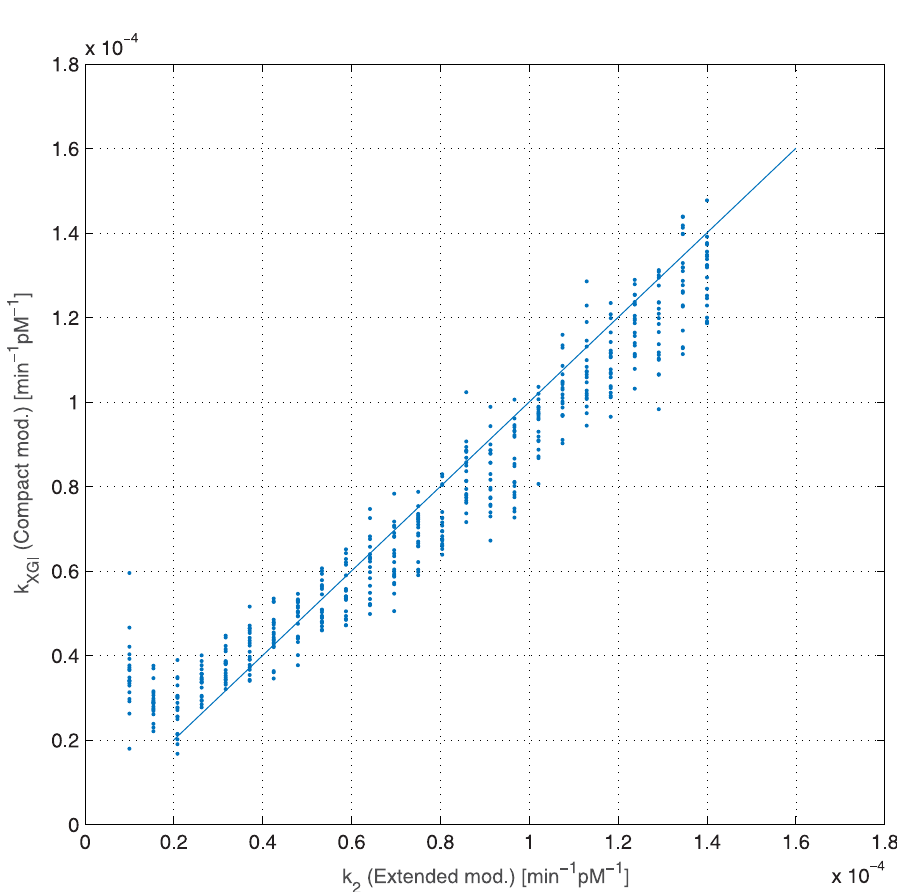
Fig 7. Dependence of estimated insulin sensitivity k (Compact Model) from generating insulin sensitivity k 2 XGI (Extended Model). Each dot represents a single virtual patient, while the line is the bisector k XGI = k 2 . Coefficient of correlation and its associated P-value: r = 0.97 ( P <